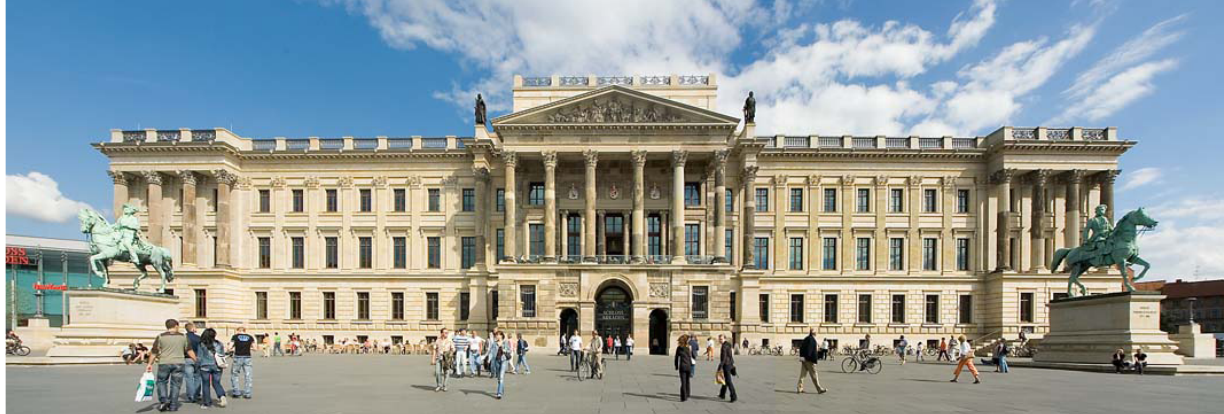
Figure 3. Reconstructed Braunschweig Palace. Source: Kudalla